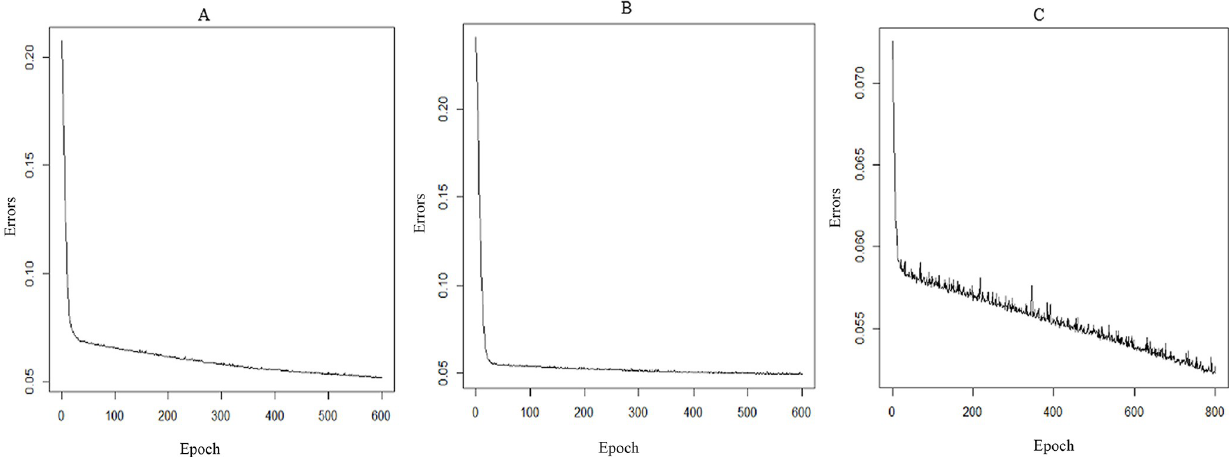
Fig 6. Epoch-error plots of the RNN9 after three training cycles. (A) First cycle, (B) Second cycle, (C) Third cycle.